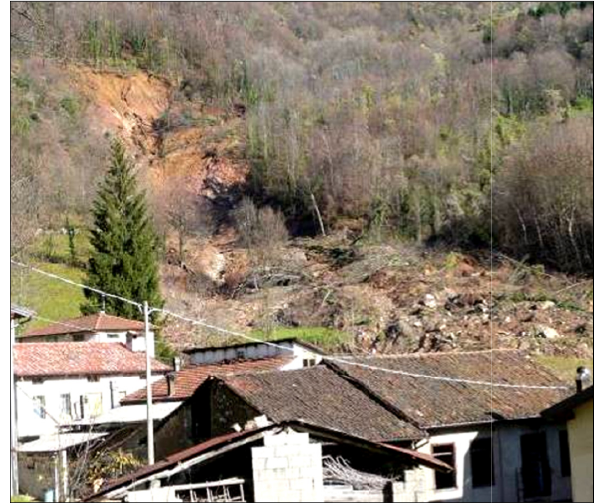
Fig. 7. View of Val di Maso landslide. In the upper part (on the left) the main scarp is visible and in the lower part (on the right) displaced materials are